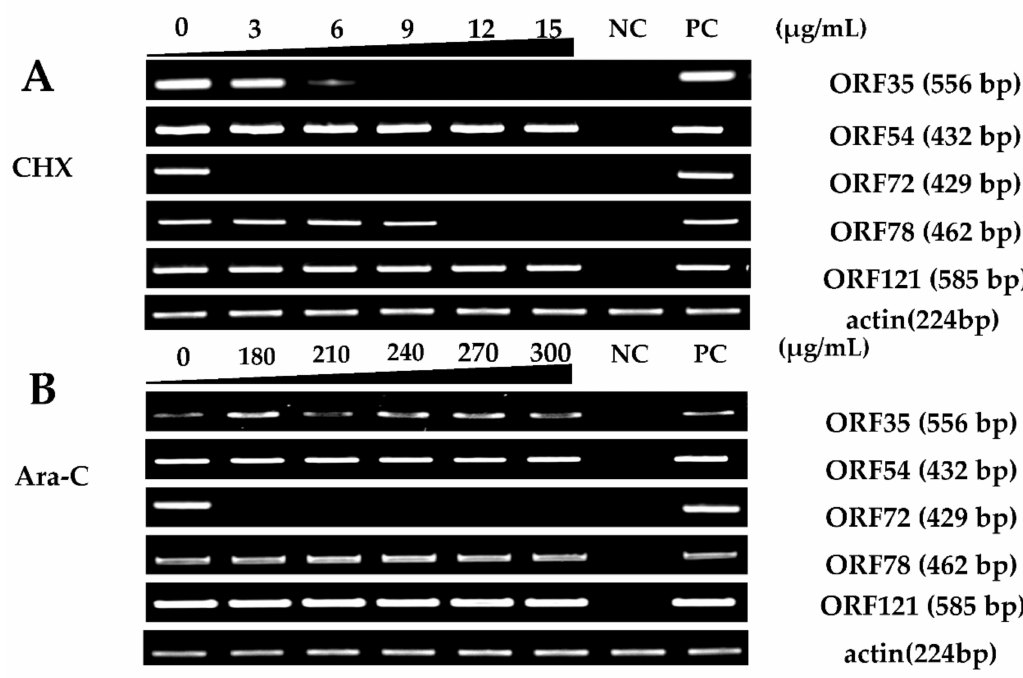
Figure 4. E ff ective concentration screening of the inhibitors. Gene expression di ff erences of five selected CyHV-2 genes in infected RyuF-2 cells were obtained using Real-Time Reverse Transcription (RT-PCR) under di ff erent concentrations of CHX (0 to 15 µ g / mL) ( A ) or Ara-C (0 to 300 µ g / mL) ( B ) treatment. Treatment of infected cells with 12~15 µ g / mL CHX or 180~300 µ g / mL Ara-C inhibited the expression of certain genes. The gene encoding actin was used as an internal control. NC: negative control; PC: CyHV-2 DNA used as positive